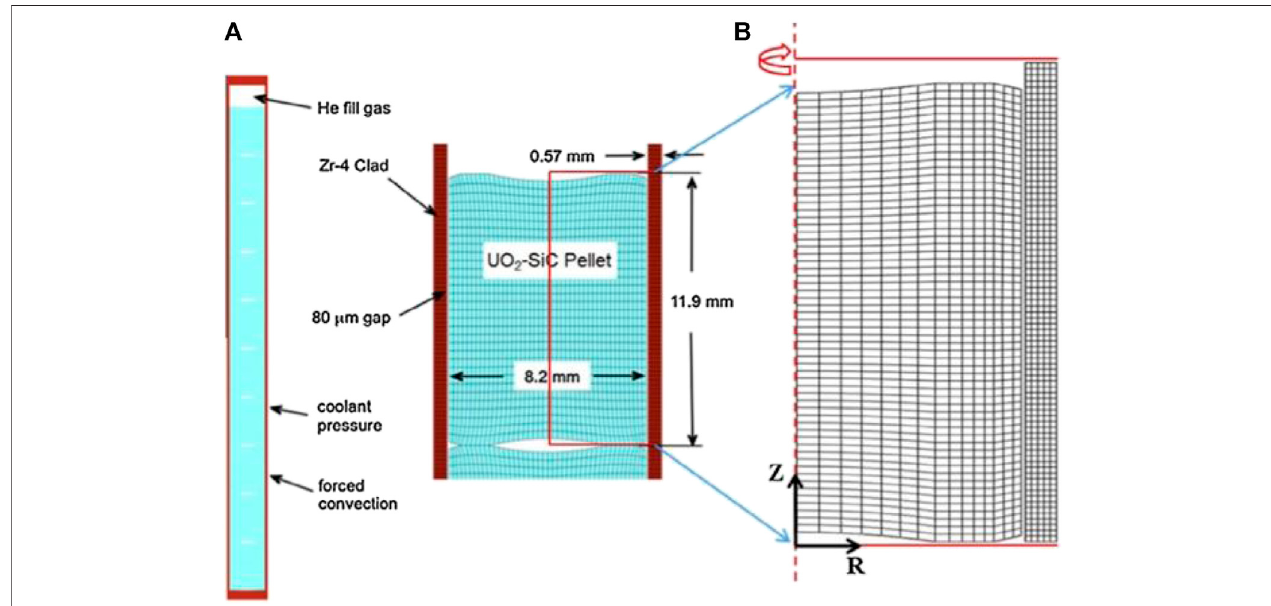
FIGURE 1 | (A) Geometry, material, and typical mesh used in COMSOL, and (B) 2D-axisymmetric geometry and mesh for a single pellet used in a previous work.